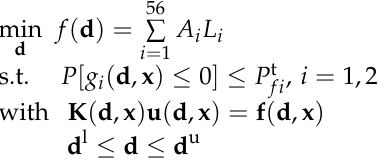
Table 14. Target failure probability and parameters for the reliability analysis and optimization. i f t P